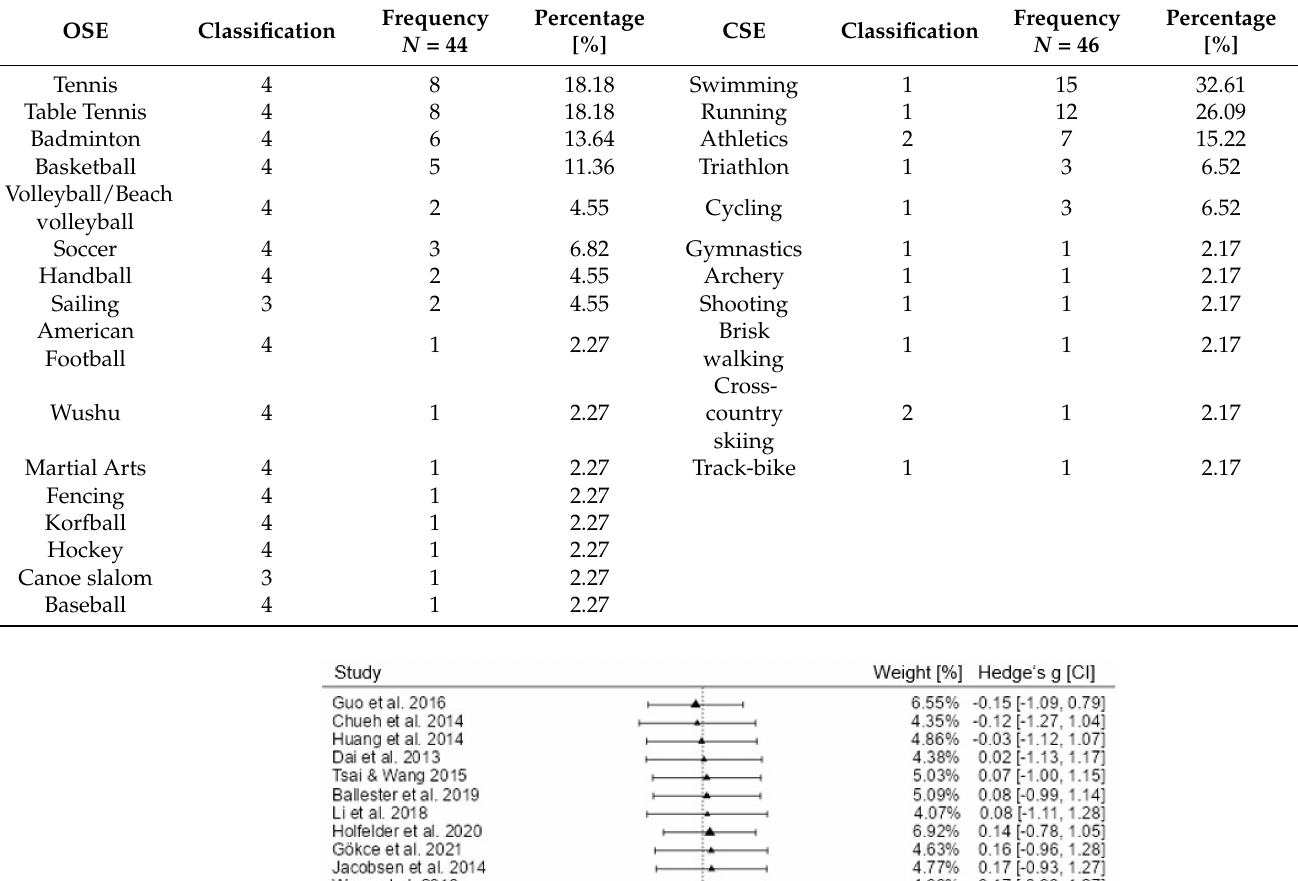
Table 1. Frequency and percentages of OSE and CSE examined and compared in the included studies.